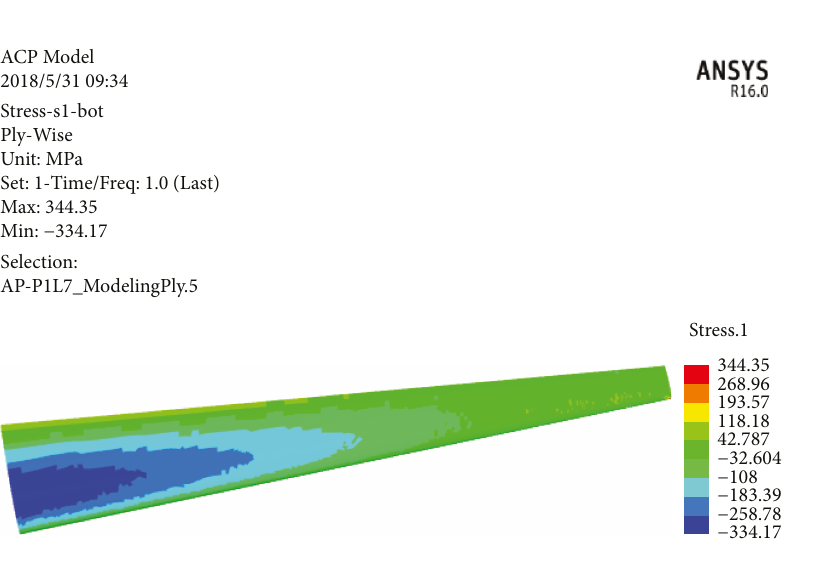
Figure 51: Stress cloud diagram of the upper wing with the layer ratio being 60%/30%/10%.